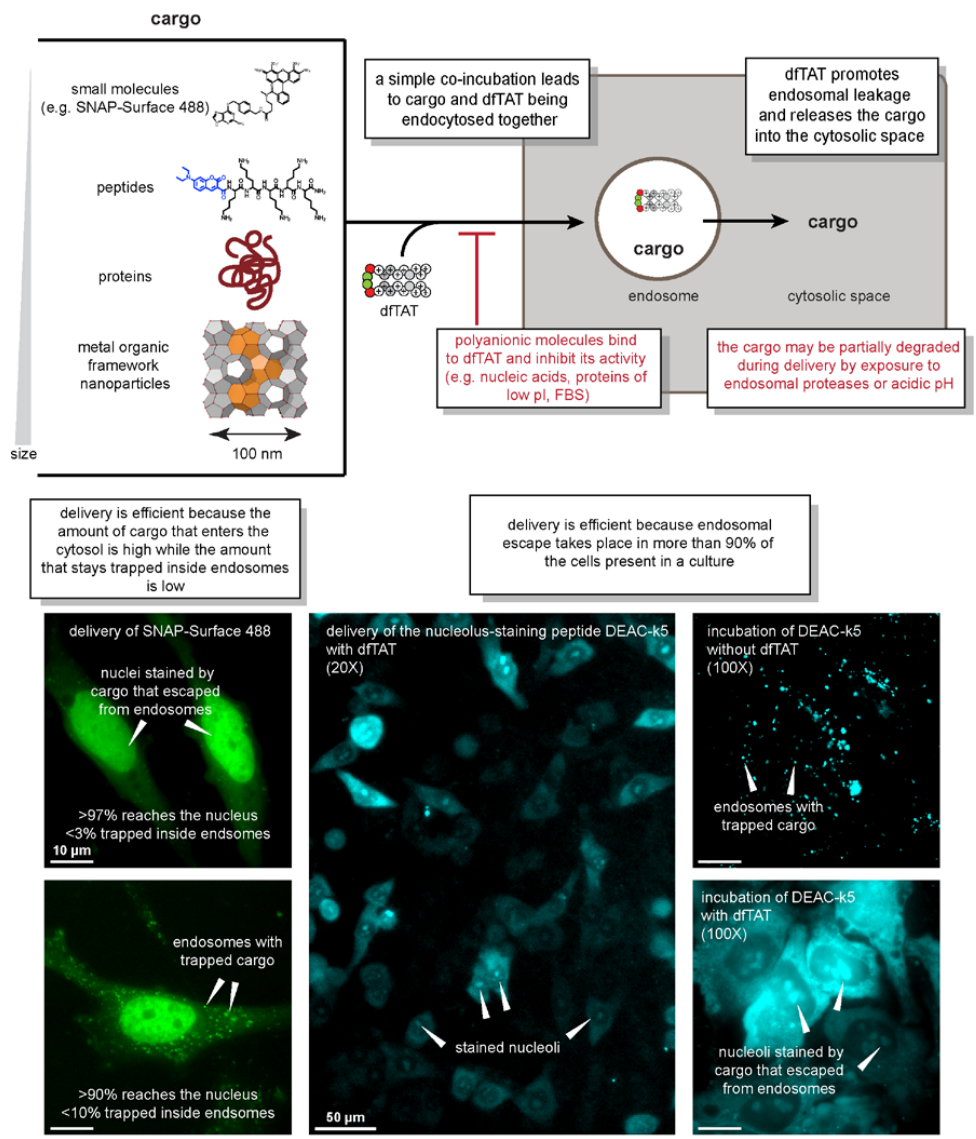
Figure 1. Macromolecular delivery by the endosomolytic cell-penetrating peptide (CPP) dfTAT in tissue cultures. dfTAT mediates cell penetration of various macromolecules by permeabilizing endosomal membranes efficiently. The stepwise process of cell entry—endocytic uptake followed by endosomal escape—is highlighted. Examples of cargos that have been successfully delivered are provided. Red